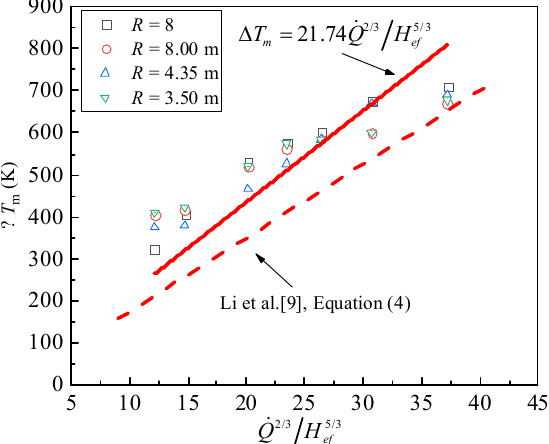
Figure 5. Prediction of maximum temperature rise ( ∆ T m ) based on Equation (5). Table 2. Empirical constants in Equation (7).